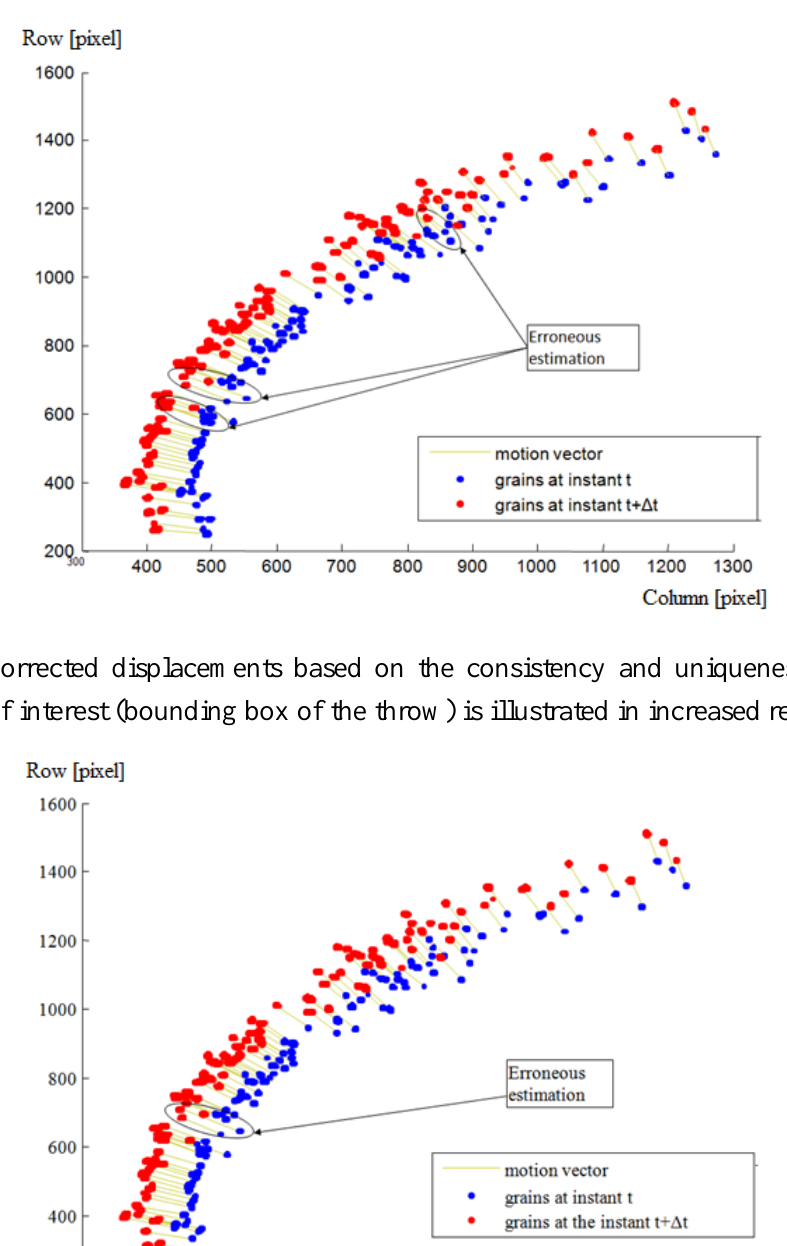
Figure 7. Estimated displacement after the first step of the motion estimation algorithm. The region of interest (bounding box of the throw) is illustrated in increased resolution.